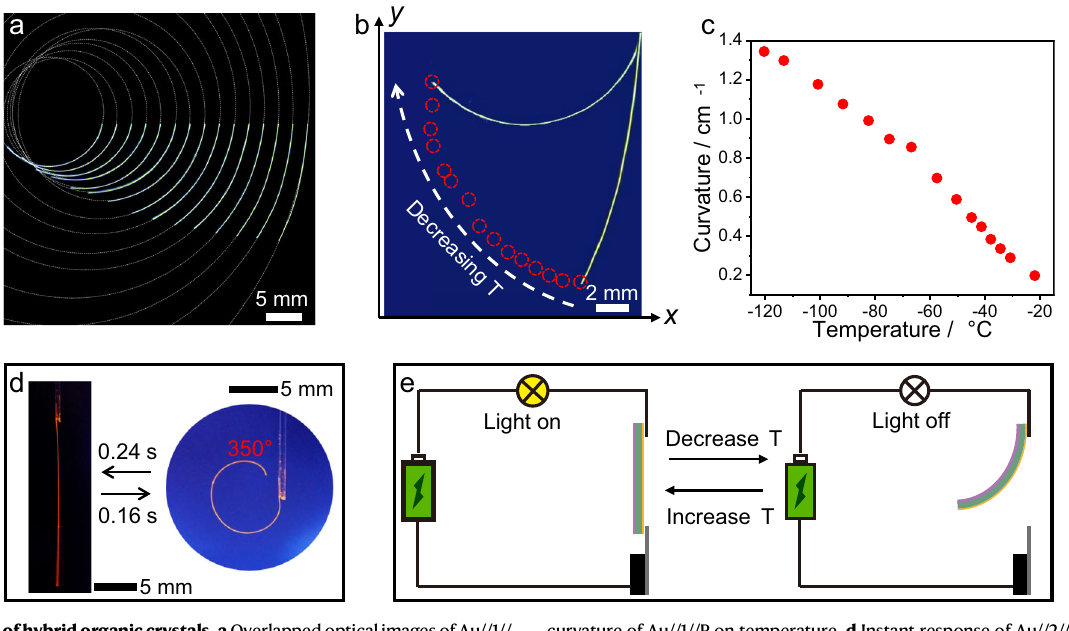
curvature of Au//1//P on temperature. d Instant response of Au//2//P with cooling andheating. e Schematicdiagramofthermalswitchingofanelectricalcircuitusing the hybrid switching